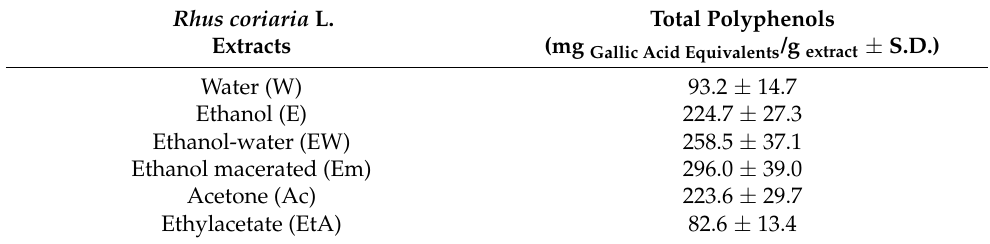
Table 1. Total polyphenol content in Rhus coriaria L.